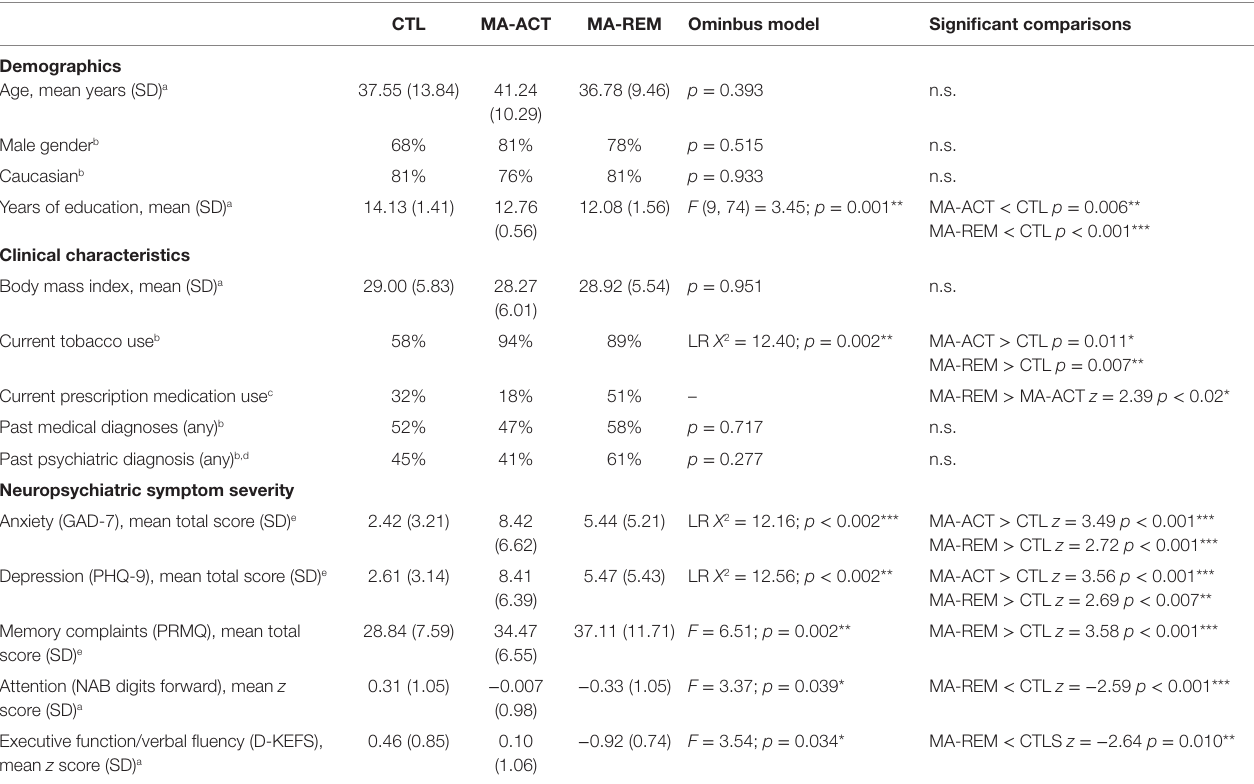
TaBle 1 | Between group comparisons of demographics, clinical characteristics, anxiety, depression, and cognition in adults with and without methamphetamine